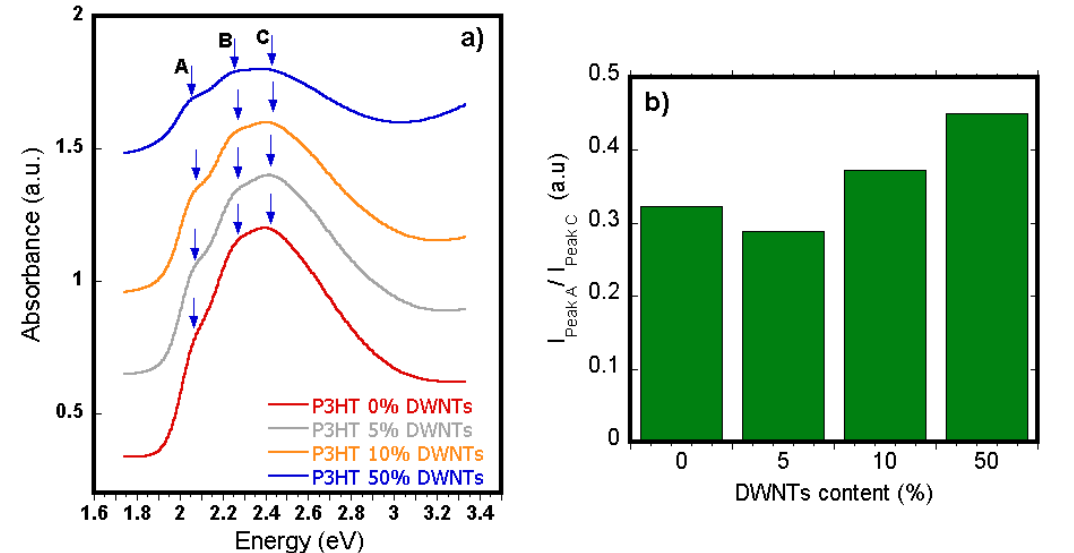
Figure 4. (a) UV-Vis spectra of P3HT-DWNTs composites. (b) UV-VRatio of the relative intensities of peaks A and C.